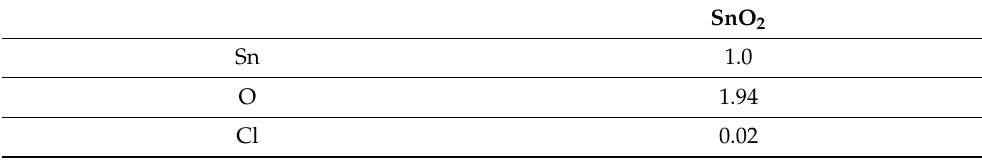
Table 1. Summary of the quantities in the undoped SnO 2 .